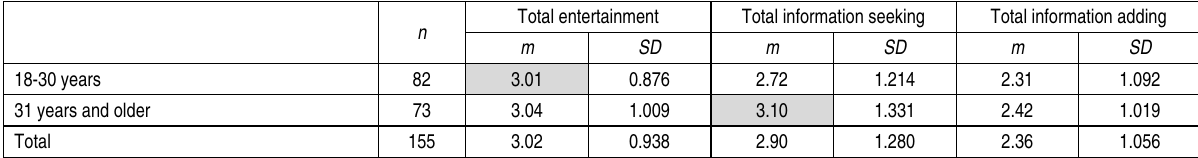
Table 3. Differences in social media usage between age groups ( n = 155) Total n